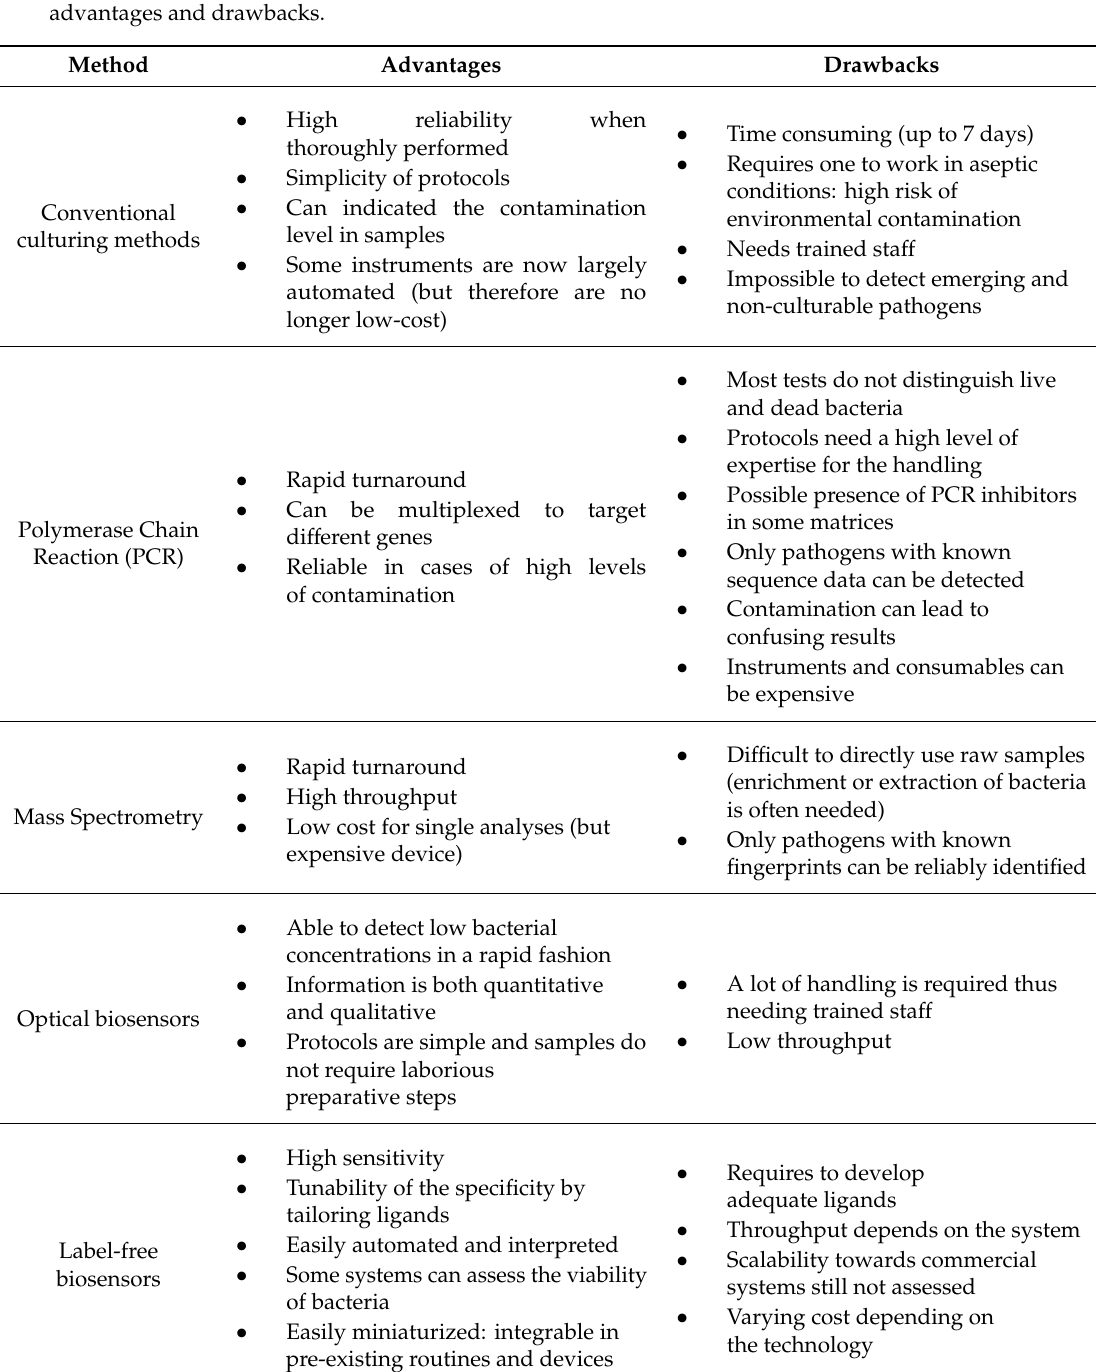
Table 3. Methods for the detection of pathogenic bacteria in clinical settings along with respective main advantages and